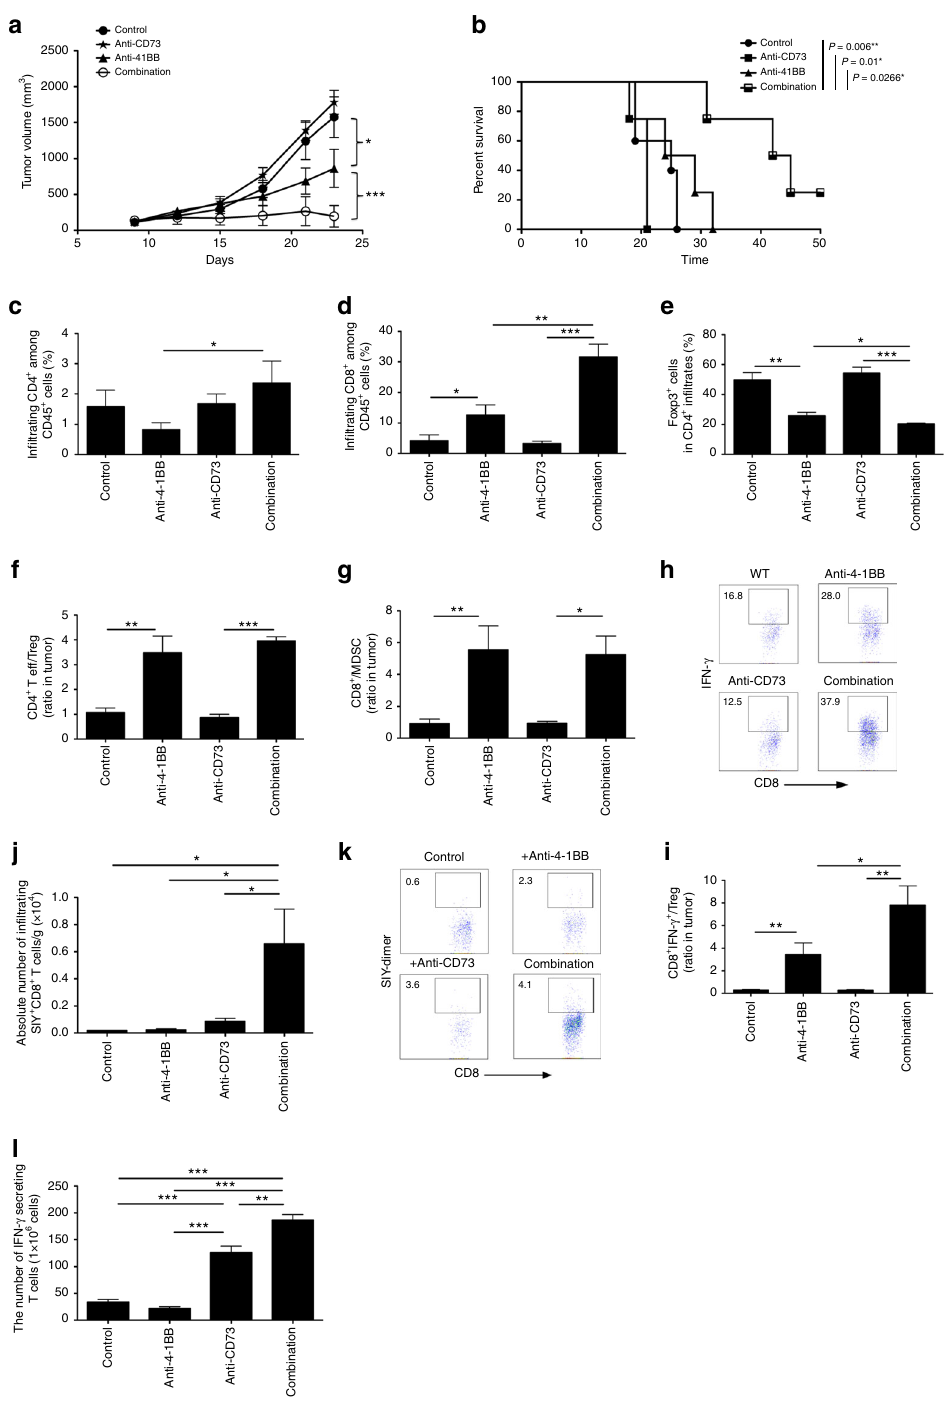
Fig. 2 Combination therapy of CD73 blockade and anti-4-1BB facilitates tumor regression. WT mice were injected s.c. with B16-SIY melanoma cells and treated with control IgG, anti-CD73, anti-4-1BB, or both anti-CD73 and anti-4-1BB. a Tumor size was measured every 2 – 3 days (5 mice per group). b Survival curves of B16-SIY-bearing mice in another independent experiment treated as indicated (8 mice per group). Percentage of CD4 + ( c ) or CD8 + ( d ) among tumor-in fi ltrating CD45 + T cells, and percentage of Foxp3 + ( e ) among total tumor-in fi ltrating CD4 + T cells in the treated B16-SIY-bearing mice as indicated. Ratios of CD4 + Foxp3 - (effectors) to CD4 + Foxp3 + (Tregs) cells ( f ), and CD8 + to Gr1 + CD11b + MDSCs ( g ). Representative fl ow dot plots for percentage of IFN- γ + in tumor-in fi ltrating CD8 + T cells ( h ), and the ratio of CD8 + IFN- γ + to CD4 + Foxp3 + Tregs ( i ). j Detection of in fi ltrating SIY-speci fi c CD8 + T cells by dimer staining from B16-SIY-bearing mice treated as indicated and ( k ) representative fl ow dot plots. l ELISPOT analysis of IFN- γ secreting CD8 + T cells from DLN of B16-SIY-bearers treated as indicated in the presence of SIY peptides (3 mice per group). The total number was counted. * p < 0.05, ** p < 0.01, *** p < 0.001. ANOVA analysis, log-rank test and unpaired Student ’ s two-tailed t test were used. Data (mean ± SEM) are representative of at least 2 independent